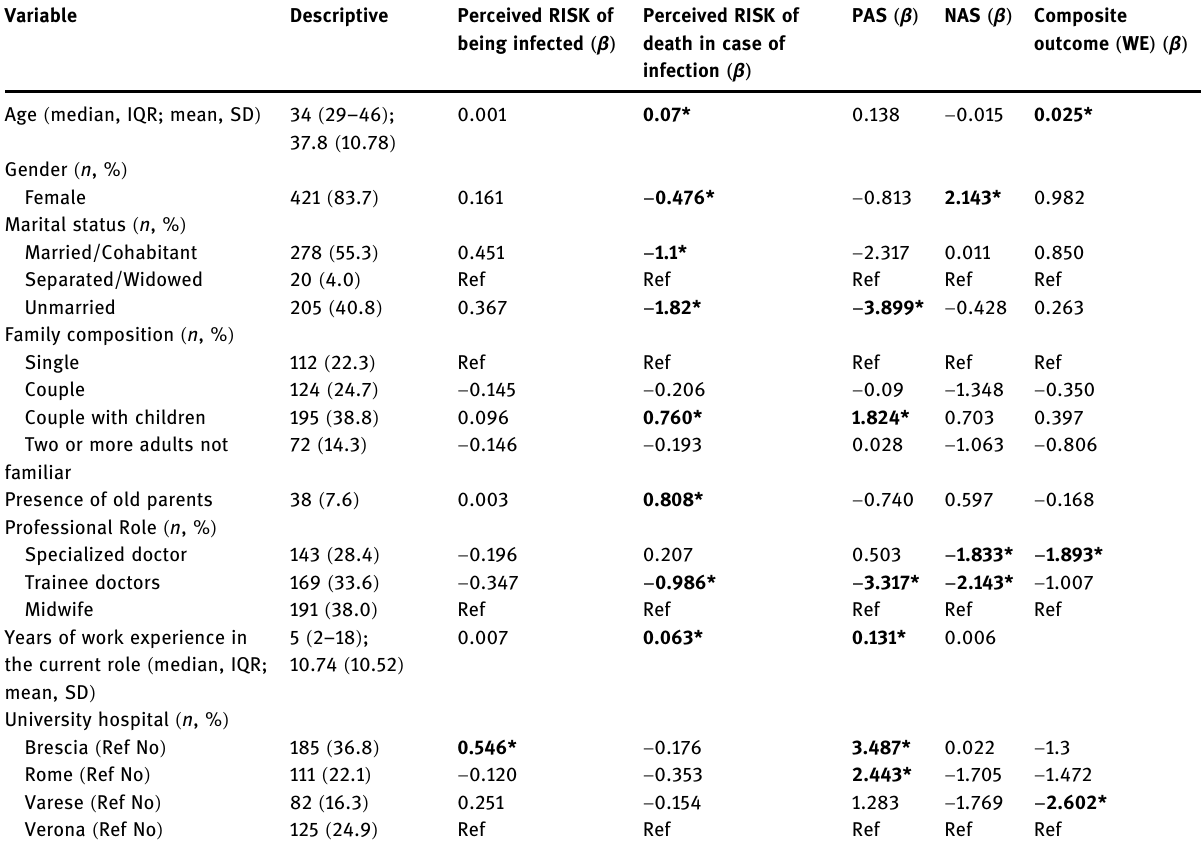
Table 1: Socio - demographic characteristics of the entire population and generalized linear model regression coe ffi cients ( β )